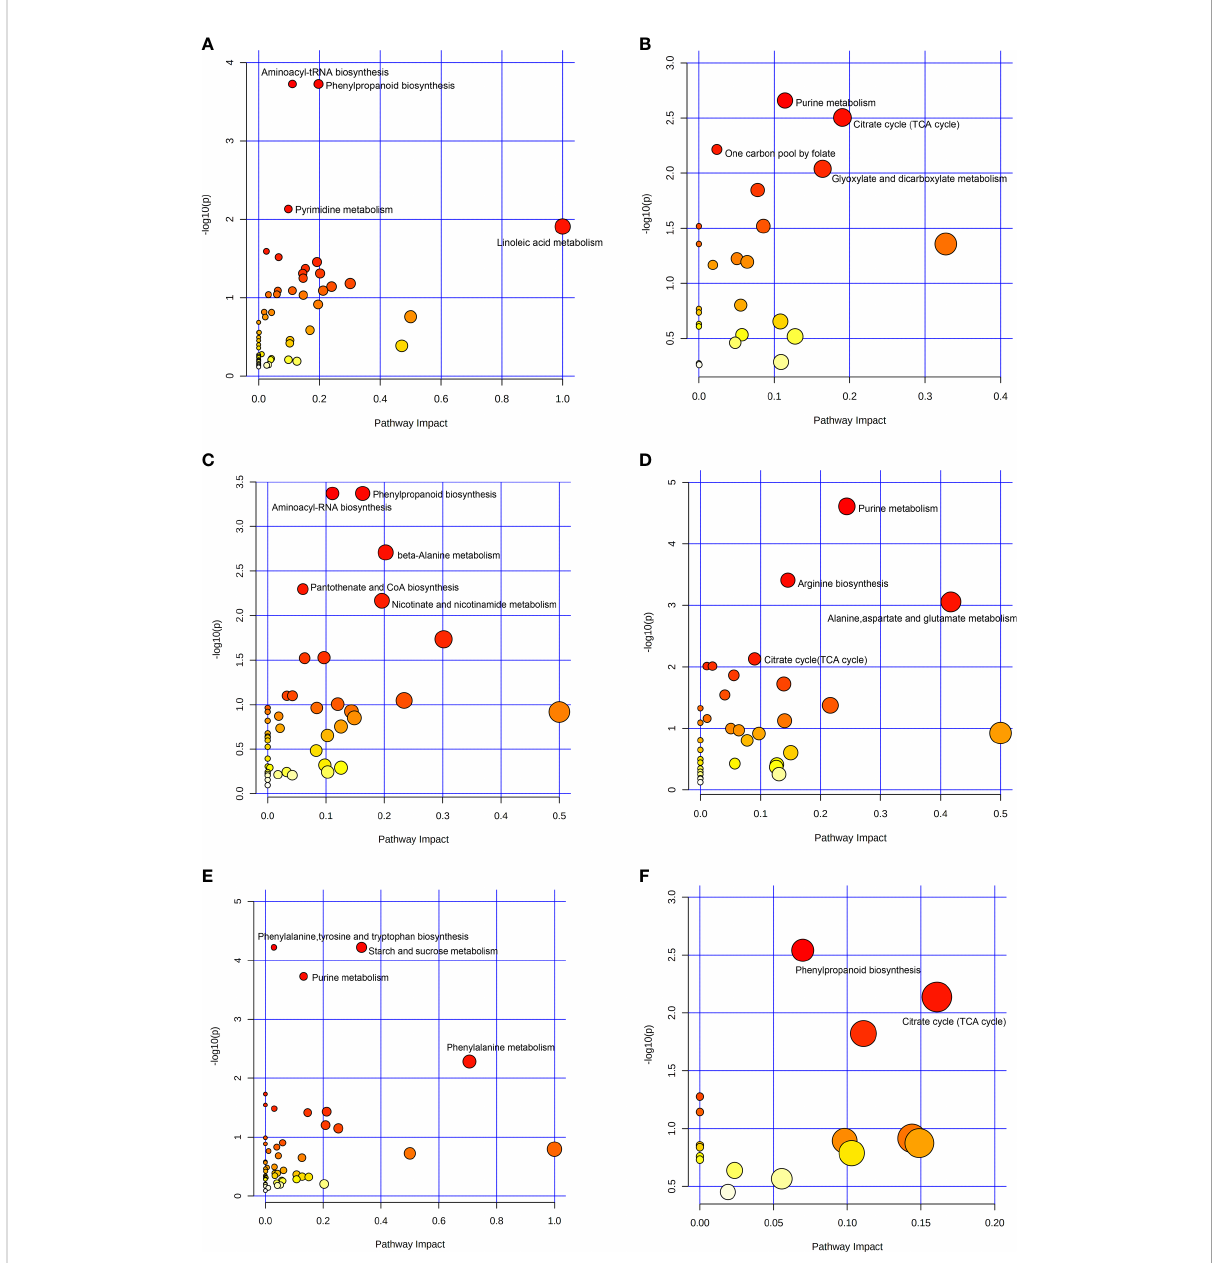
FIGURE 3 Bubble plot of KEGG pathway enrichment analysis. (A) Metabolic pathways of up-regulated differential metabolites at Low-altitude vs High- altitude. (B) Metabolic pathways of down-regulated differential metabolites at Low-altitude vs High-altitude. (C) Metabolic pathways of up- regulated differential metabolites at Low-altitude vs Mid-altitude. (D) Metabolic pathways of down-regulated differential metabolites at Low- altitude vs Mid-altitude. (E) Metabolic pathways of up-regulated differential metabolites at Mid-altitude vs High-altitude. (F) Metabolic pathways of down-regulated differential metabolites at Mid-altitude vs